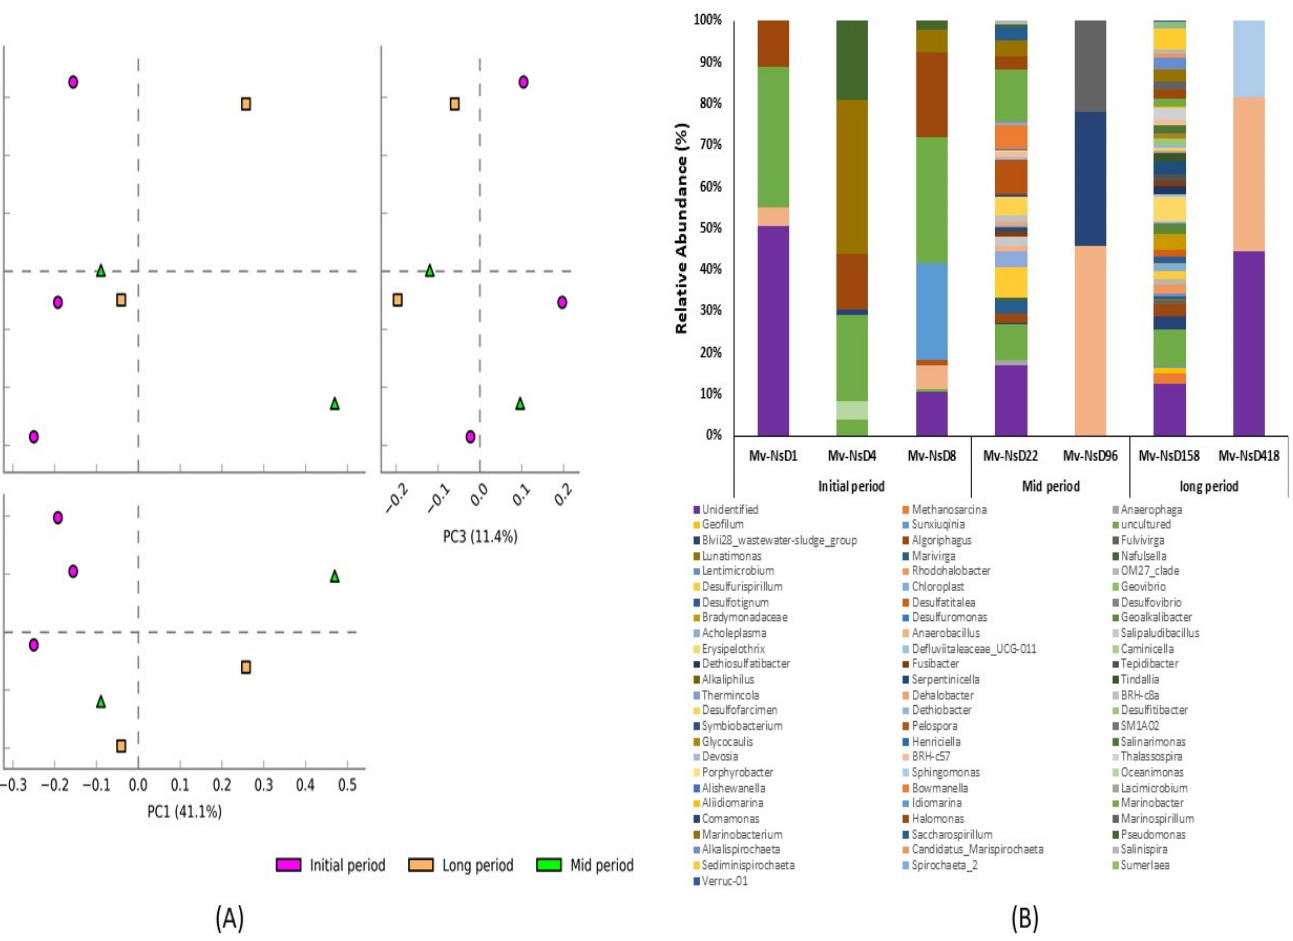
Figure 4. Diversity and relative abundance of bacterial genera of the samples collected at the initial, mid, and long periods after volcanic eruption. ( A ) PCA plots showing the grouping of samples based on the bacterial community structure of the samples collected at various time intervals, which exhibited the distribution pattern and uniqueness of the samples. ( B ) Stacked bar graphs illustrating the abundance of genera associated with the samples collected at various time intervals after the volcanic eruption. Higher bacterial diversity was noted in the samples from days 22 and 158, while lower diversity was observed in the samples from days 1, 96, and 418.